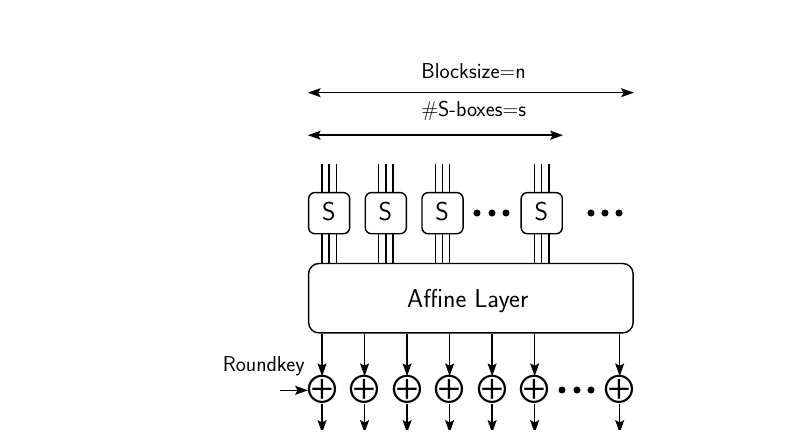
Figure 1: LowMC Round